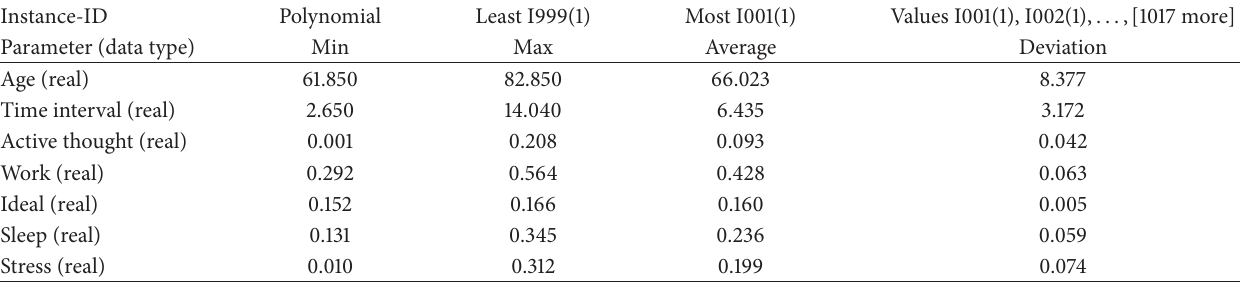
Table 4: Statistical inferences of activity level in the elderly.